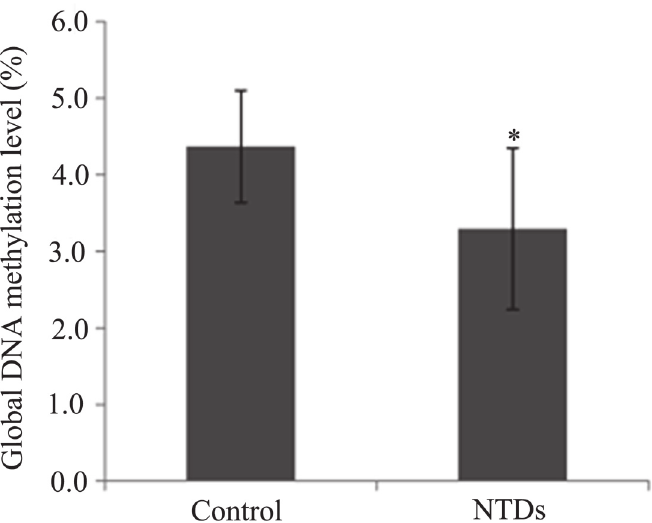
Fig 1. Methylation levels in NTDs and control groups. * P < 0.05 NTDs versus